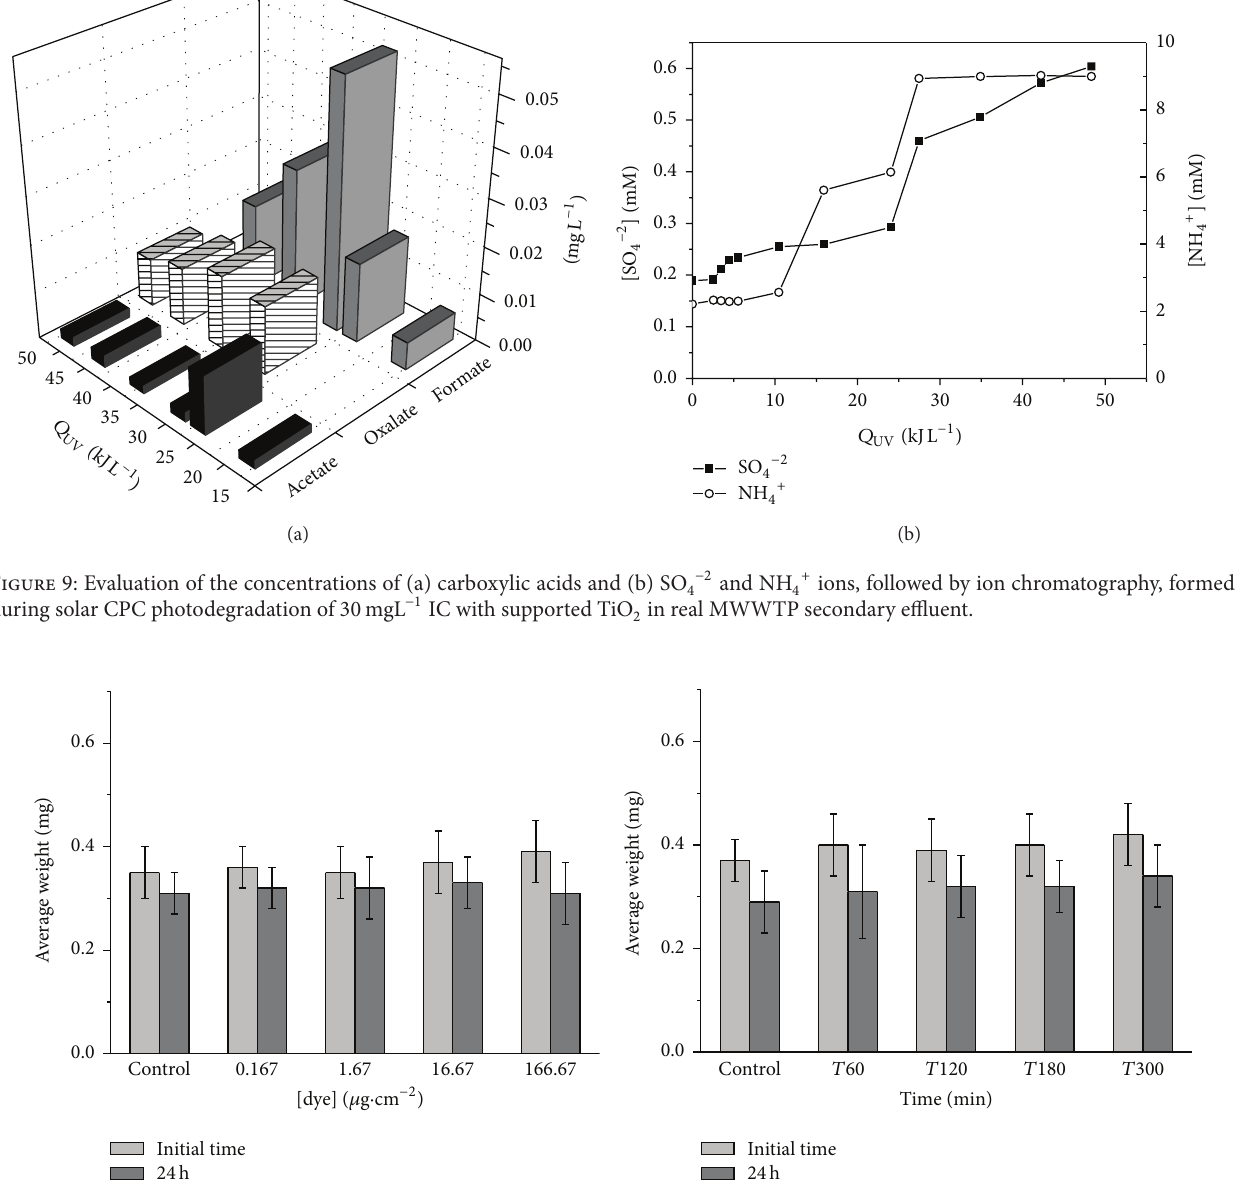
Figure 10: Acute ecotoxicology test by Eisenia andrei earthworms: (a) different initial IC concentrations and (b) IC (80mgL −1 ) photoproducts at different